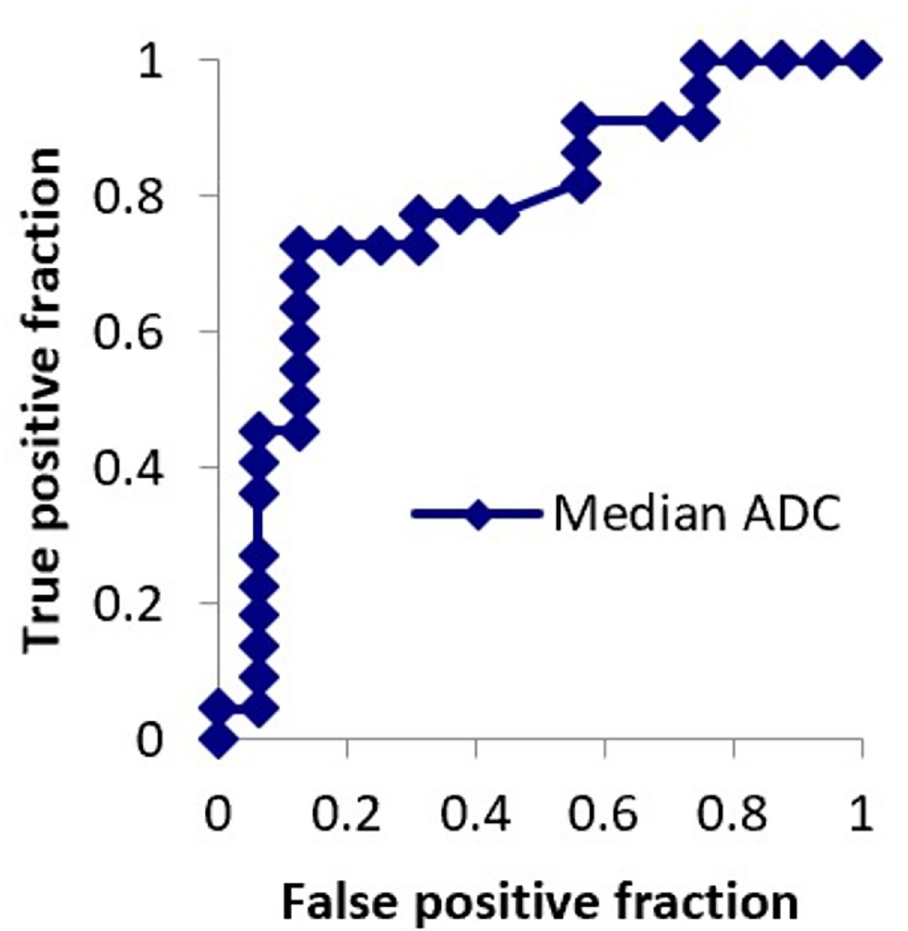
Fig 2. Receiver-operating characteristic (ROC) curve for median apparent diffusion coefficient. The area under the ROC curve is 0.784.